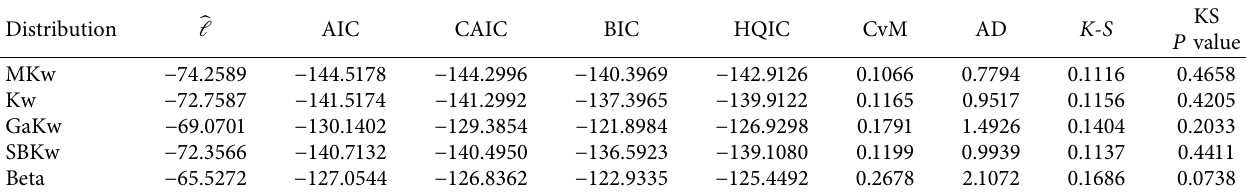
Table 15: Te statistics AIC, CAIC, BIC, HQIC, CvM, AD, and K - S for data set 4.